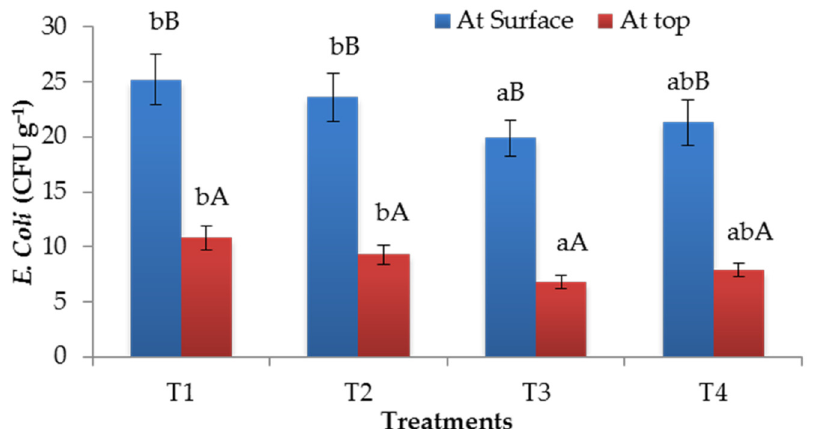
Figure 7. Incidence of E. coli in bitter gourd fruit located at di ff erent heights. “At surface” means the bitter gourd fruit was near the soil surface (at a height of 0.2 to 0.3 m) while “at top” means the fruit was 1 m vertically from the soil surface. Vertical bars for each column represent standard deviation ( n = 3) of the mean. Means of di ff erent treatments followed by the di ff erent lowercase letters (a,b) are significantly di ff erent ( p < 0.05) for the same location vertically, whereas the di ff erent uppercase letters (A,B) are significantly di ff erent ( p < 0.05) between the di ff erent location heights.